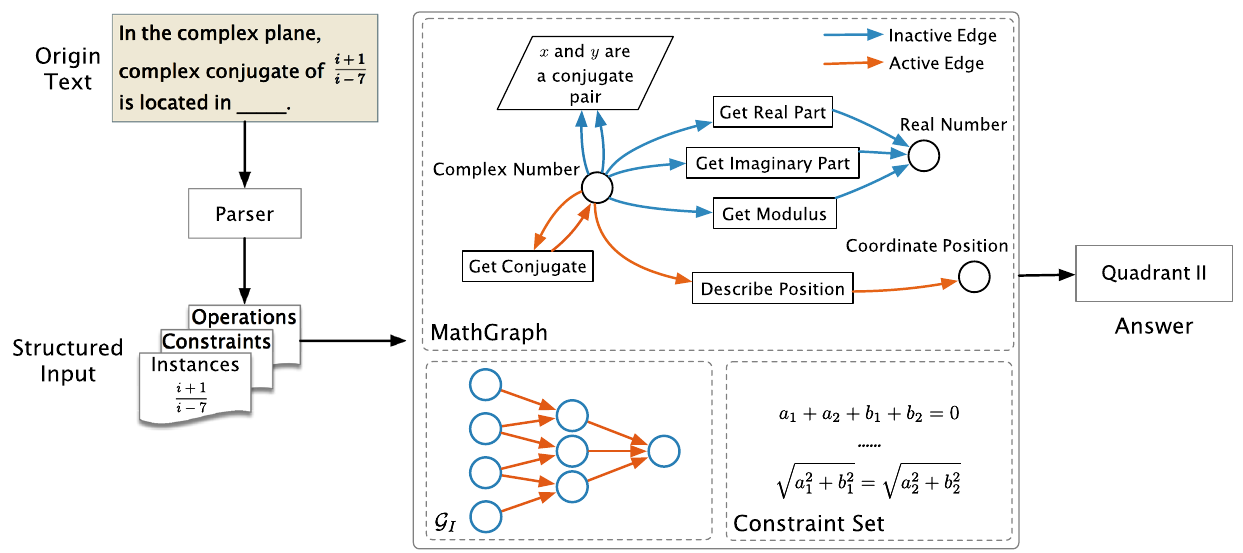
Fig. 1 Overview of using MathGraph to solve a mathematical